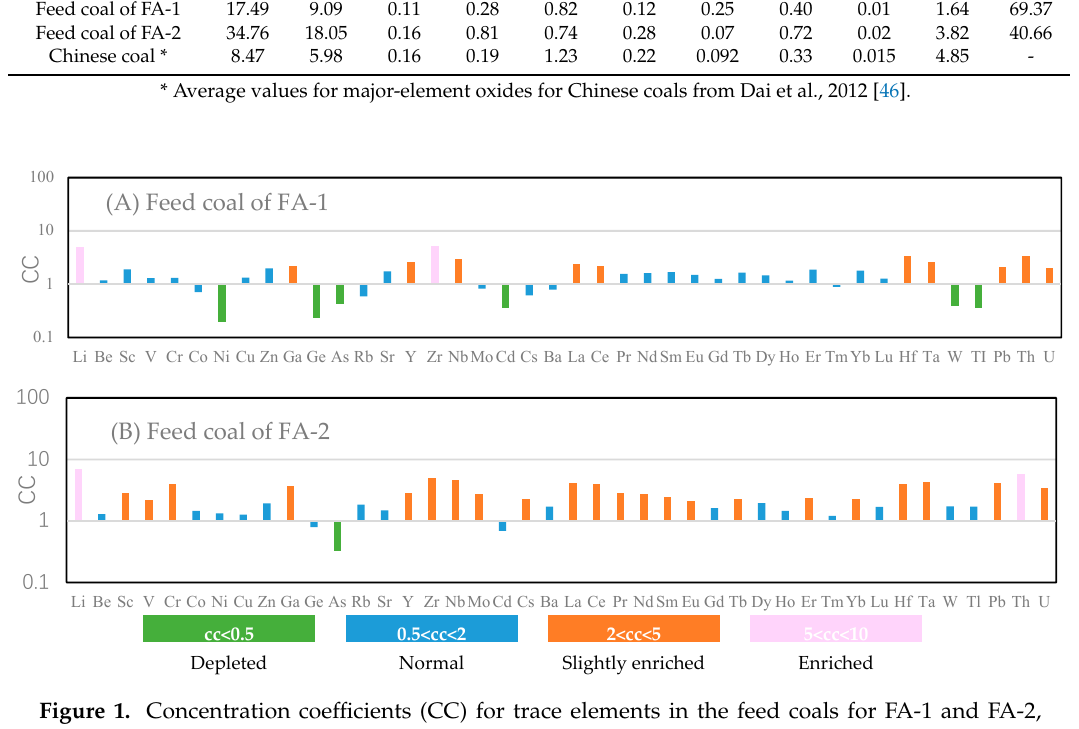
Table 2. Chemical composition of the feed coals for FA–1 and FA-2.